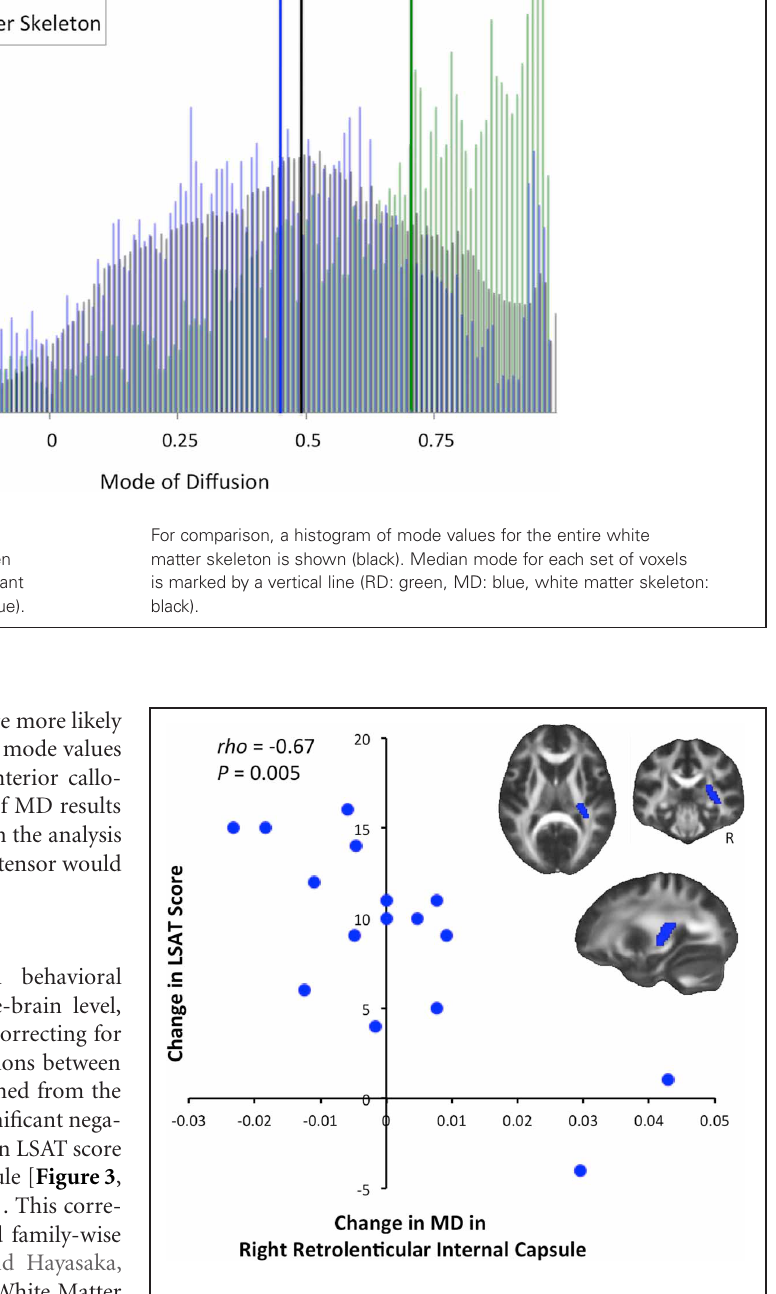
FIGURE 3 | Correlation between LSAT improvement and MD decrease. LSAT change and MD change were significantly negatively correlated [Spearman’s rho = − 0.667, P (uncorrected) = 0.005, P (corrected) = 0.02] in the right retrolenticular part of the internal capsule, an anatomical ROI defined from the JHU Label Atlas. Slices shown are: X = 27, Y = − 29, Z =